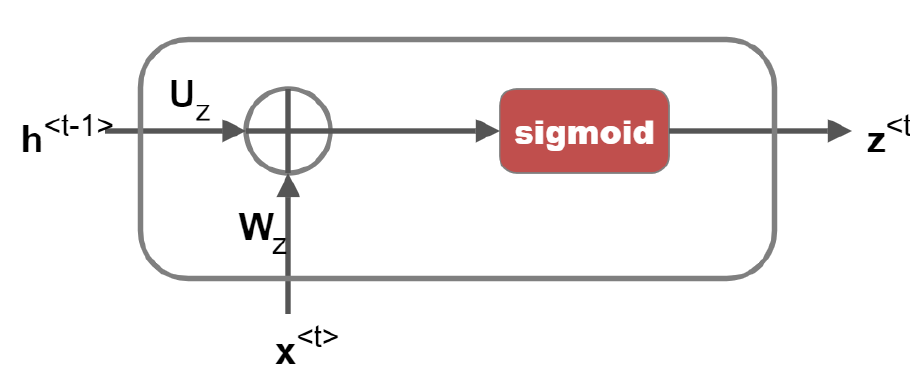
Figure 2. Update Gate.